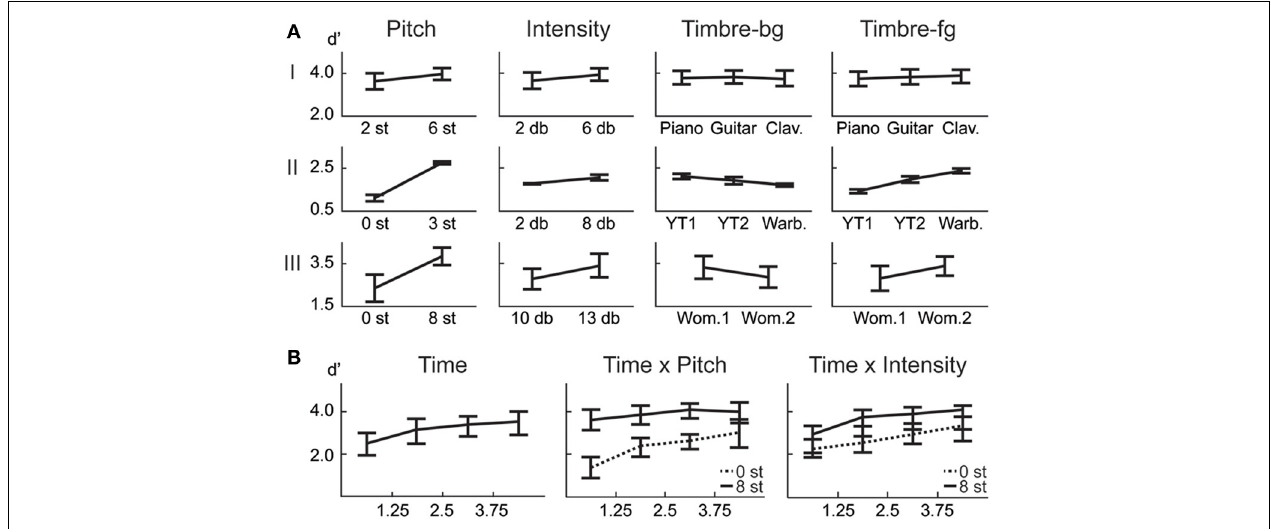
FIGURE 2 | Behavioral results. (A) ANOVA main effect trends for all experiments. (B) The effect of the time factor reveals a temporal build-up observed in human detection of saliency. Interaction of time with pitch and intensity are shown. The significance levels corresponding to these plots can be found in Table 2 .